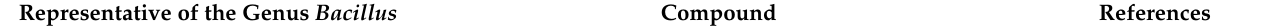
Table 7. The compounds produced by bacteria of the genus Bacillus , which are important for the control of material biodamage. Representative of the Genus